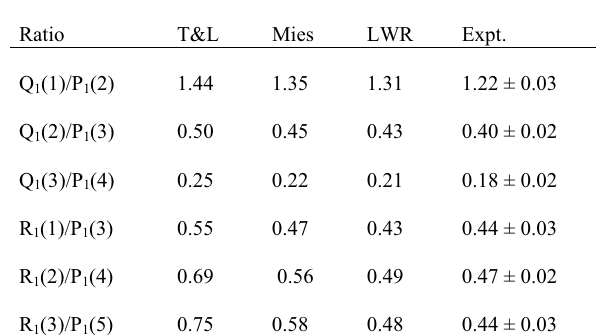
Table 4. OH(8–3) temperature-insensitive intensity ratios derived from T&L, Mies and LWR transition probabilities and values deter- mined from the summed high-resolution spectrum in Fig.